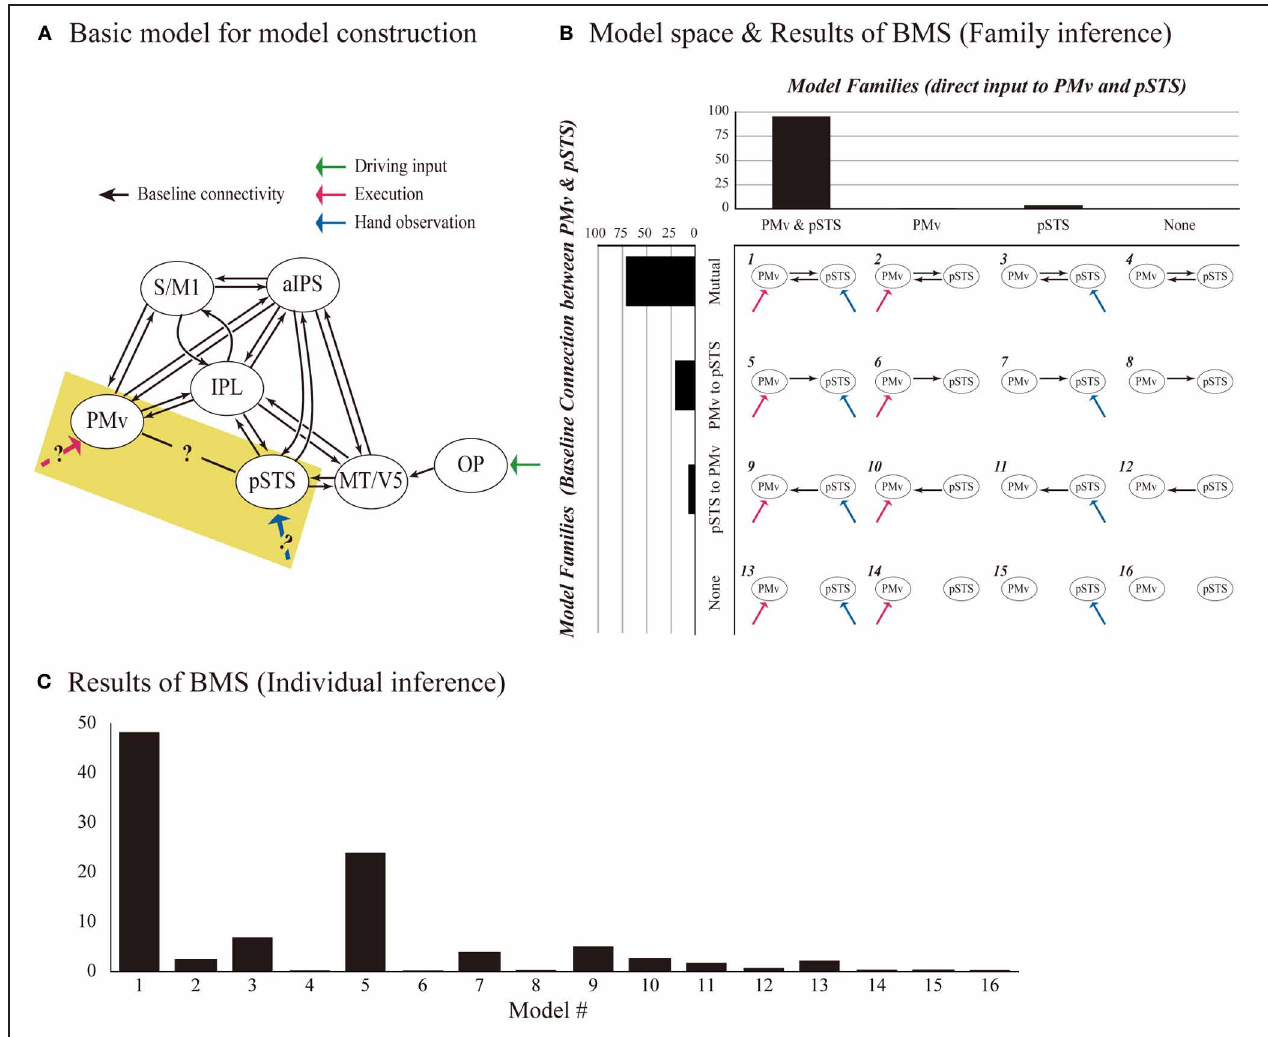
of the input of Execution to the PMv and the input of Hand observation to the pSTS. We assumed that the two experimental factors (Execution and Hand observation) modulated all baseline connectivity. Upper bar graph shows the exceedance probability (%) of the four families partitioned by the patterns of the direct input to PMv and pSTS. Left bar graph indicates the exceedance probability (%) of four families based on the baseline connectivity between PMv and pSTS. (C) BMS-exceedance probability (%) resulted from 16 model comparison with individual inference. The number of model (horizontal axis) corresponds to the number shown in (B) .